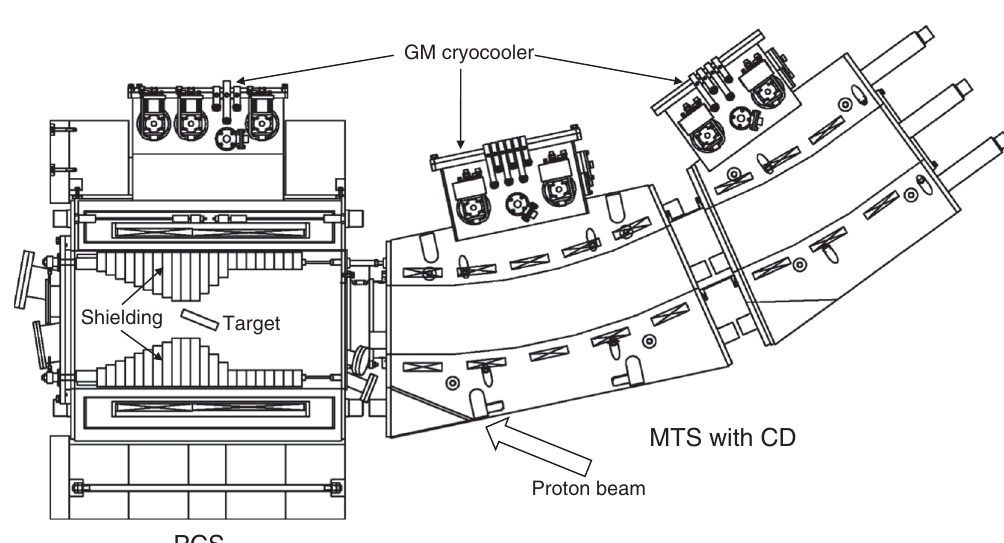
FIG. 1. Layout of the MuSIC beam line showing the target surrounded by shielding and the PCS. To the right are the two modules of five and three element coils, respectively, of the MTS, covering an arc of 36°. Each coil in the MTS includes a correction dipole (CD). All superconducting coils are cooled with conduction cooling using Gifford-McMahon (GM) cryocoolers. The direction of the incoming proton beam is also